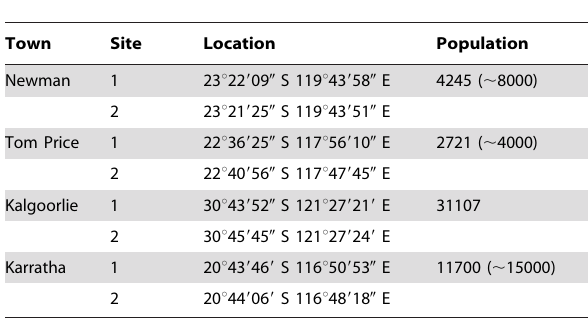
Table 1. Geographical location and estimated populations of permanent residents of the towns where the geogenic PM 10 was